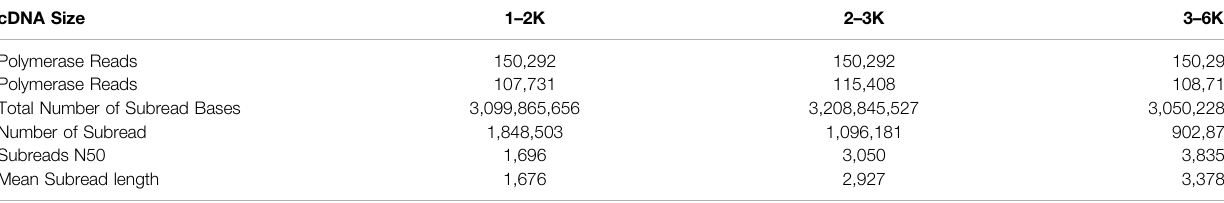
TABLE 1 | Data statistics from Pacbio transcriptome sequencing. cDNA Size